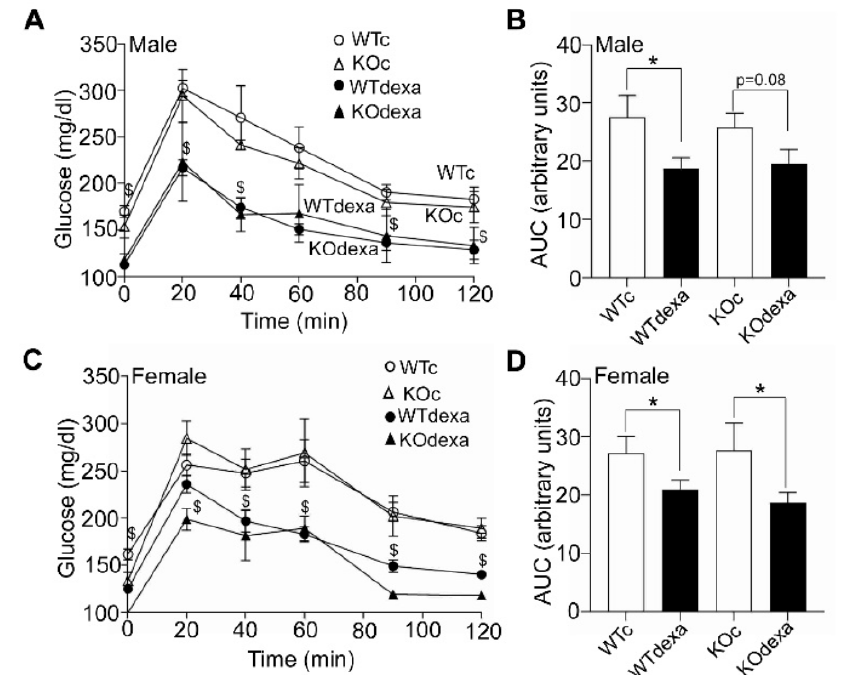
Figure 2. Intraperitoneal glucose tolerance tests (IPGTTs). ( A ) IPGTT in male WT and Nrf2 KO mice treated with vehicle or dexamethasone for 12 weeks. ( B ) Area under the curve (AUC) of the IPGTT of male mice. ( C ) IPGTT in female WT and Nrf2 KO mice treated with vehicle or dexamethasone for 12 weeks. ( D ) Area under the curve (AUC) of the IPGTT of female mice. * p < 0.05 of the indicated comparison, $ p < 0.05 of the dexamethasone-treated mice (either WT or Nrf2 KO) versus the corresponding vehicle-treated mice of the same